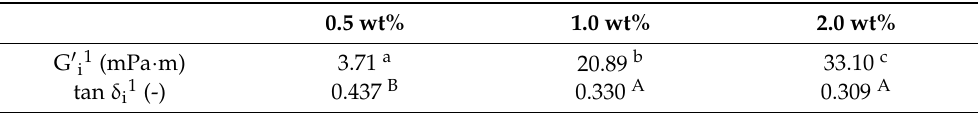
Table 3. Interfacial elastic modulus (G (cid:48) i ) and interfacial loss tangent (tan δ i ) at 0.1 Hz for the three systems tested. Different letters show significant differences ( p <